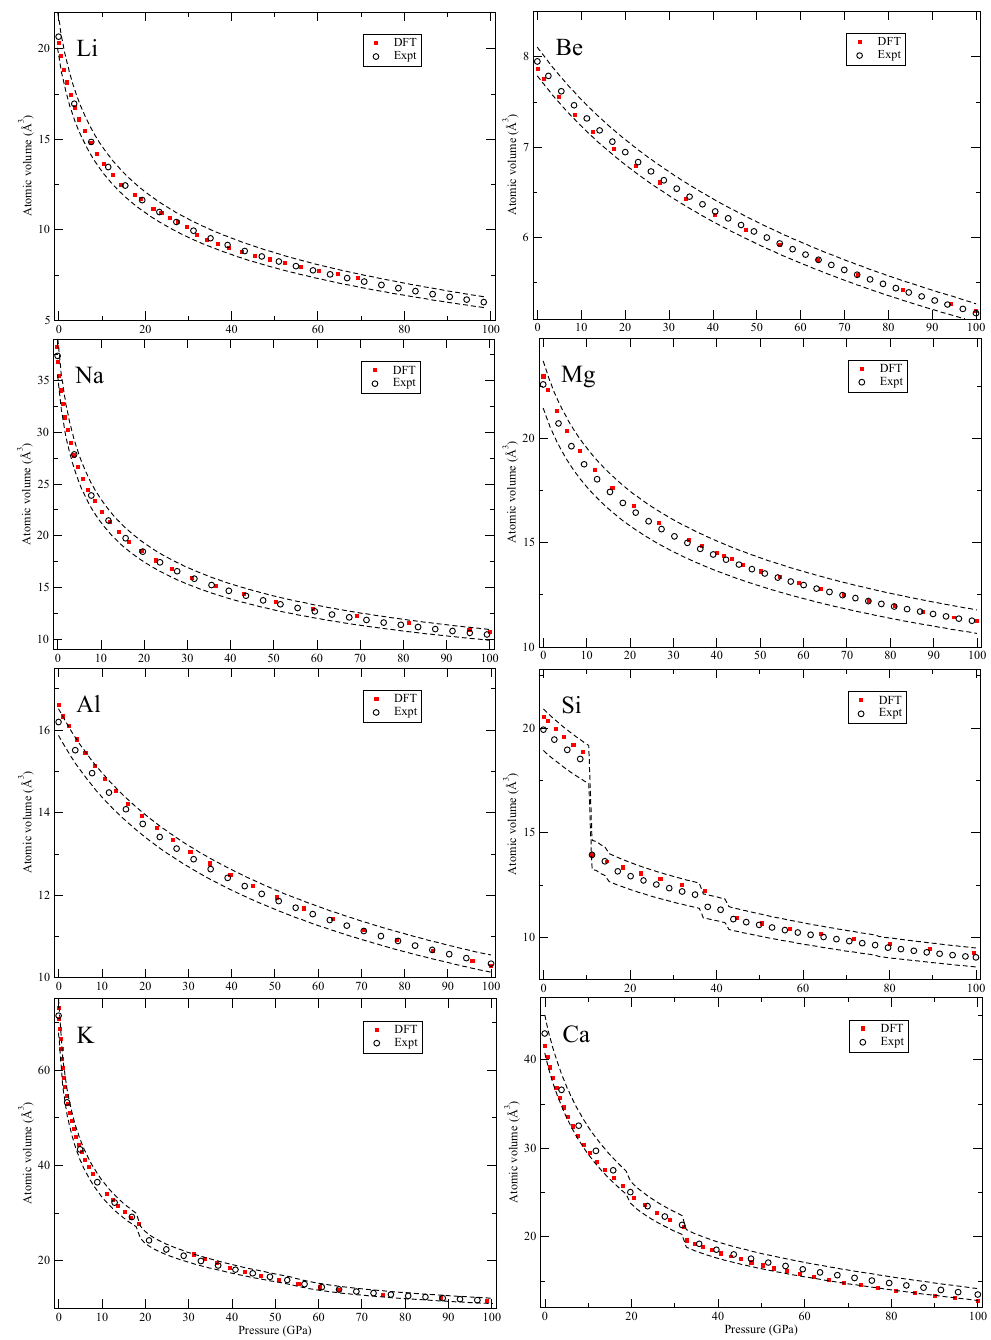
Figure 2. Experimental and DFT EOS for Li, Be, Na, Mg, Al, Si, K and Ca.